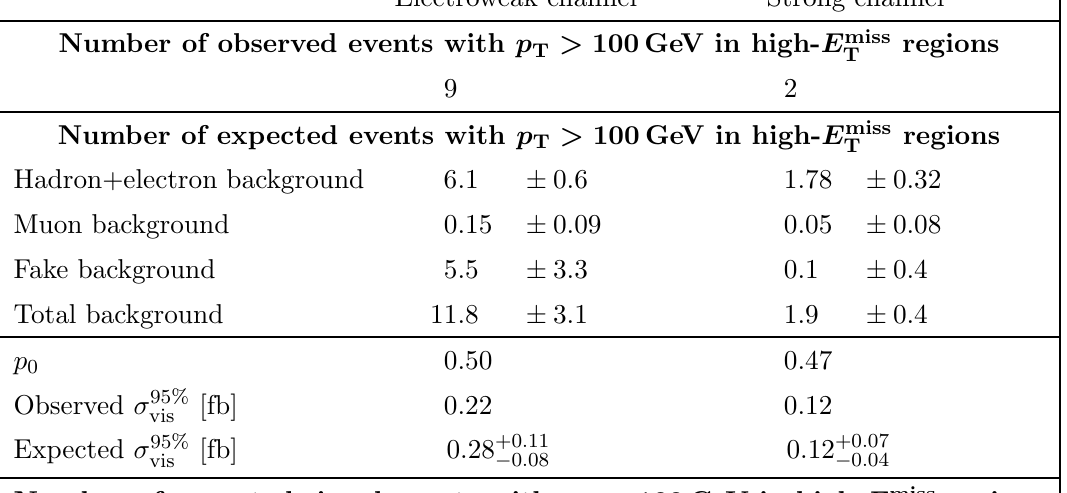
; (cid:28) ) = (400 GeV ; 0 : 2 ns) and strong channel ~ (cid:31) (cid:6) 1 ~ (cid:31) (cid:6) 1 region. Also shown are the T